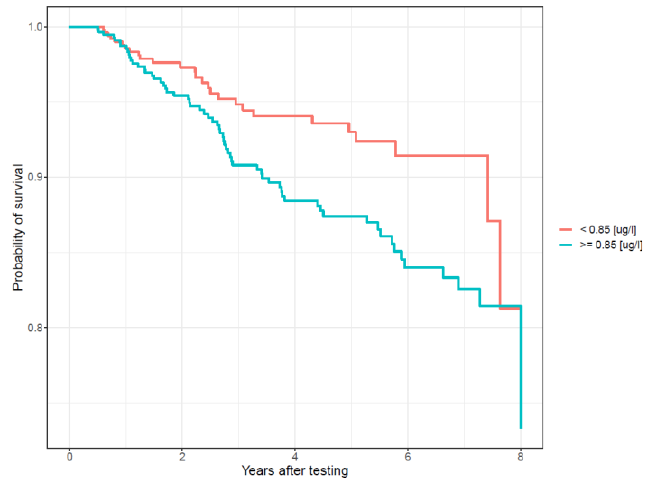
Figure 2. Probability of cancer-free survival stratified by median total blood arsenic levels (µg/L).